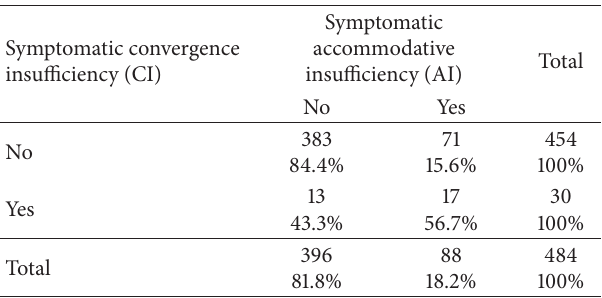
Table 3: Relation between symptomatic convergence insufficiency and symptomatic accommodative insufficiency.